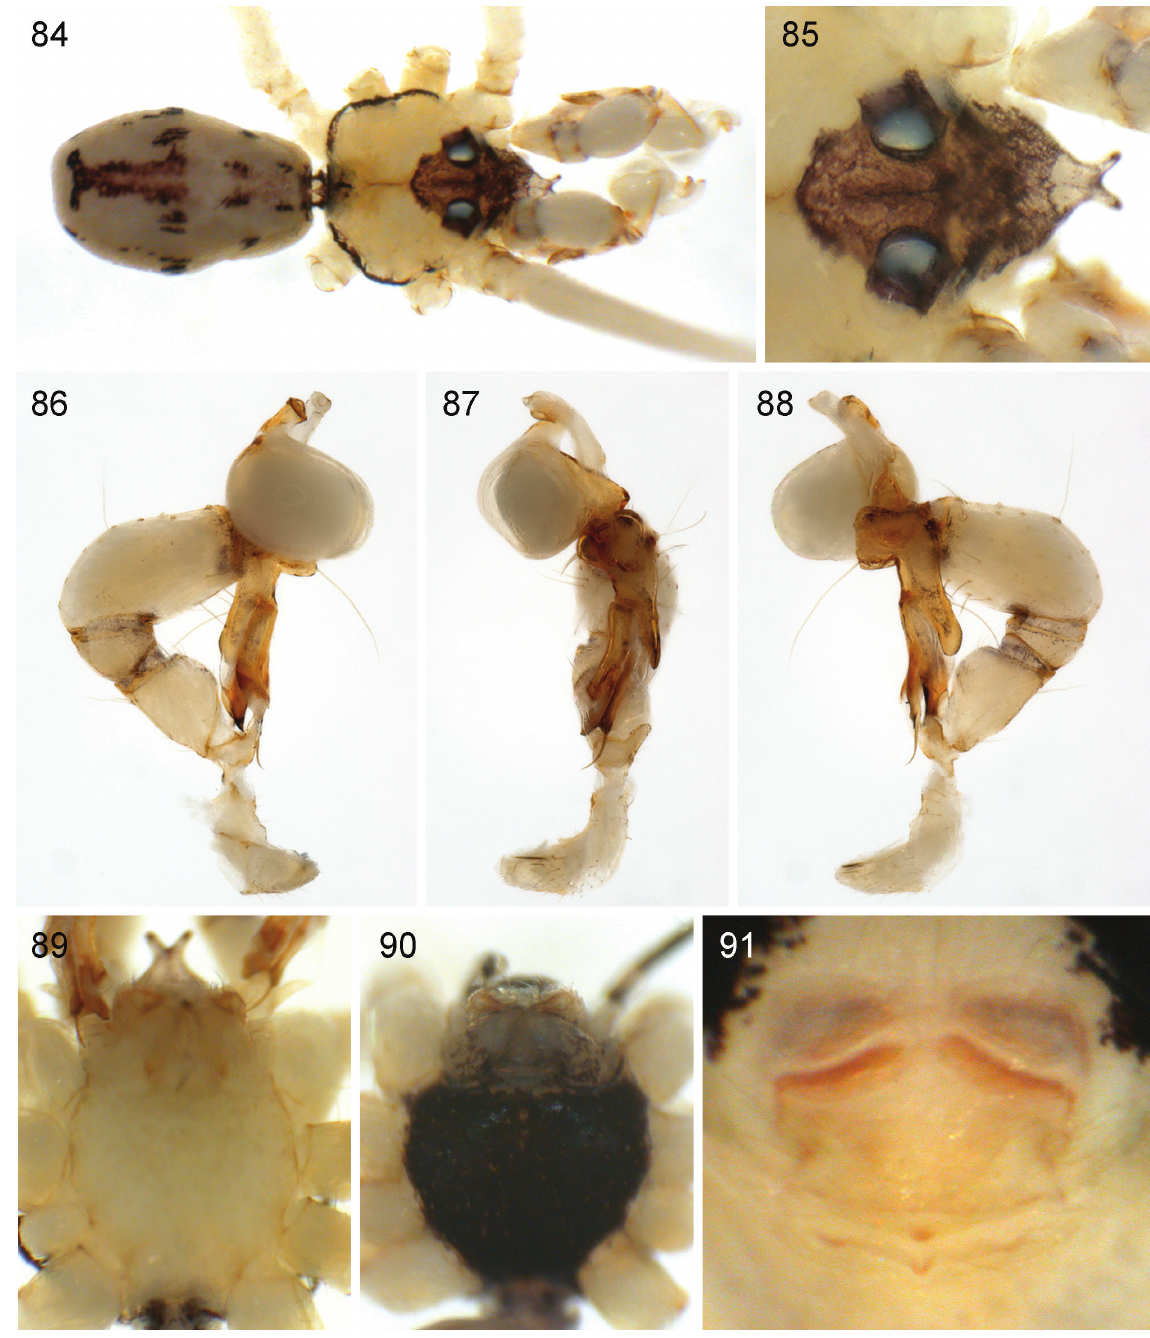
Figs 84-91. Spermophora abibae sp. nov. 84 . ♂, dorsal view. 85 . ♂ ocular area and clypeus, dorsal view. 86-88 . Left ♂ palp, prolateral, dorsal, and retrolateral views. 89-90 . ♂ and ♀ prosomata, ventral views. 91 . ♀ epigynum, ventral